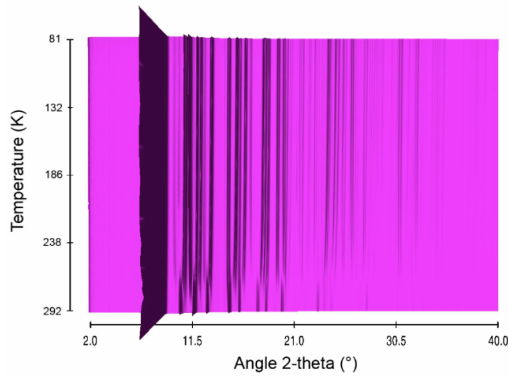
Figure 5. Sequential plot of the diffraction patterns of HBB within the range of temperature 81–292